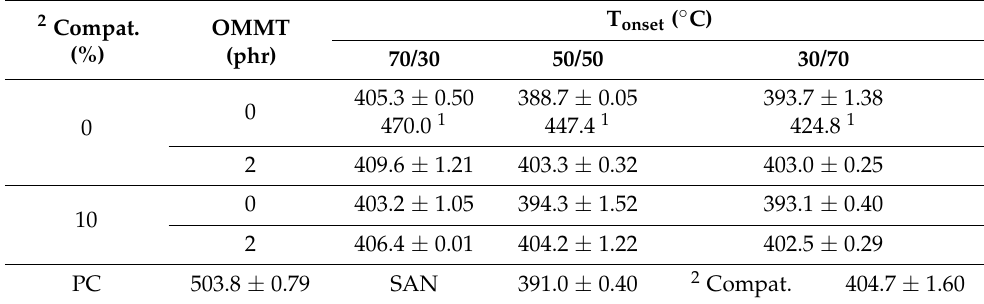
Table 2. Onset decomposition temperature (T onset ) of non-compatibilized and compatibilized (with ABS-g-MAH) PC/SAN blends and their